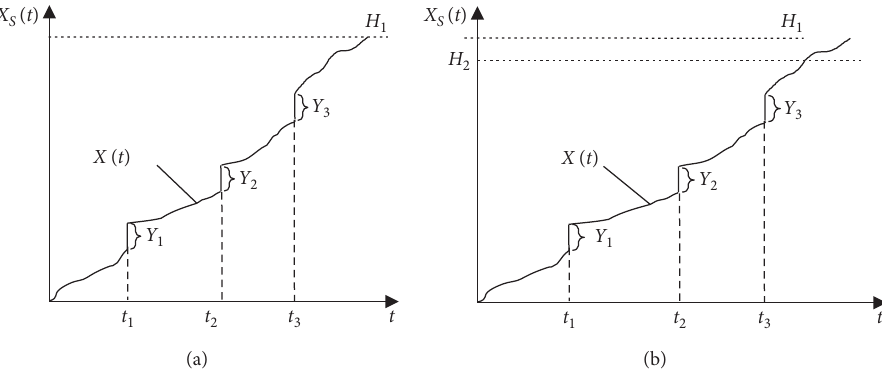
Figure 1: Soft failure process: (a) fixed threshold; (b) shifting threshold.